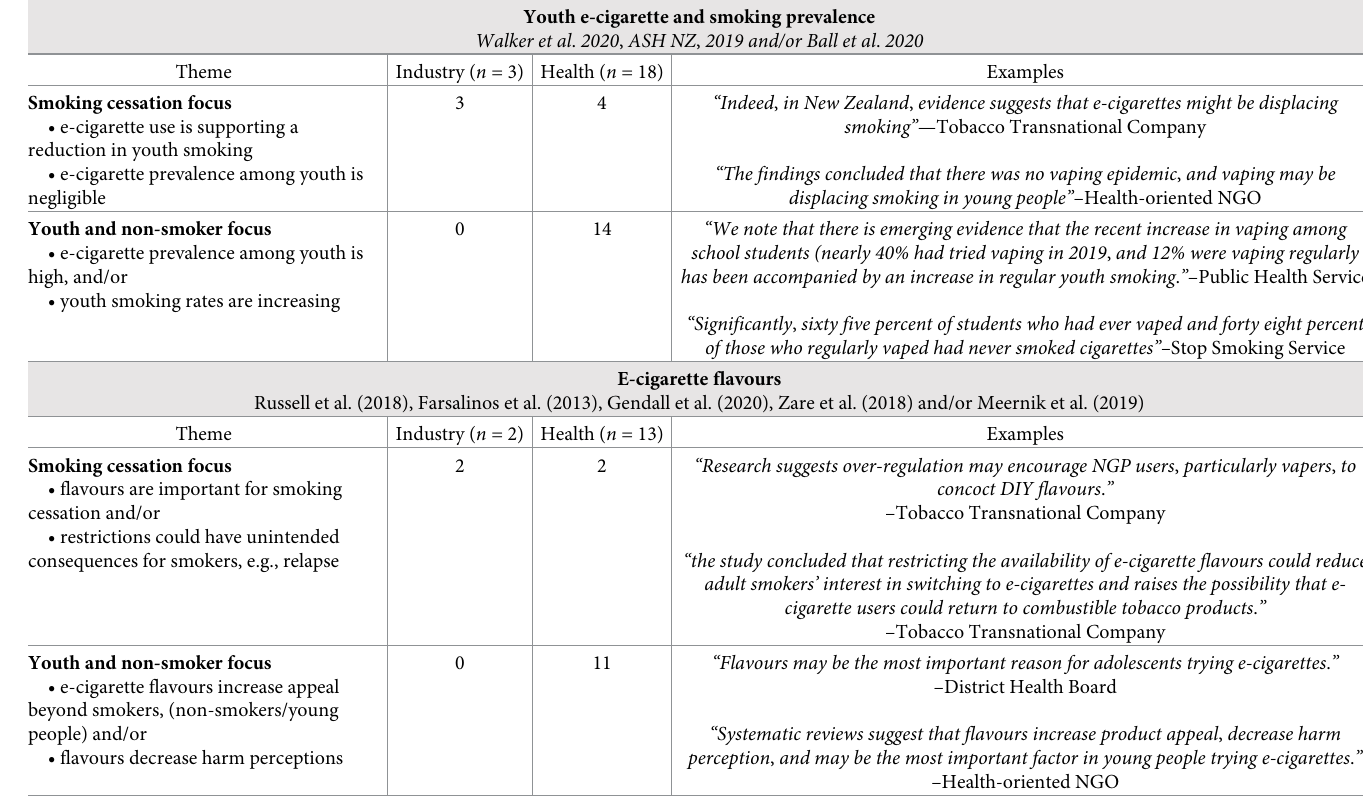
Table 3. Number and position of organisations that utilised frequently cited evidence relating to ‘youth prevalence’ and